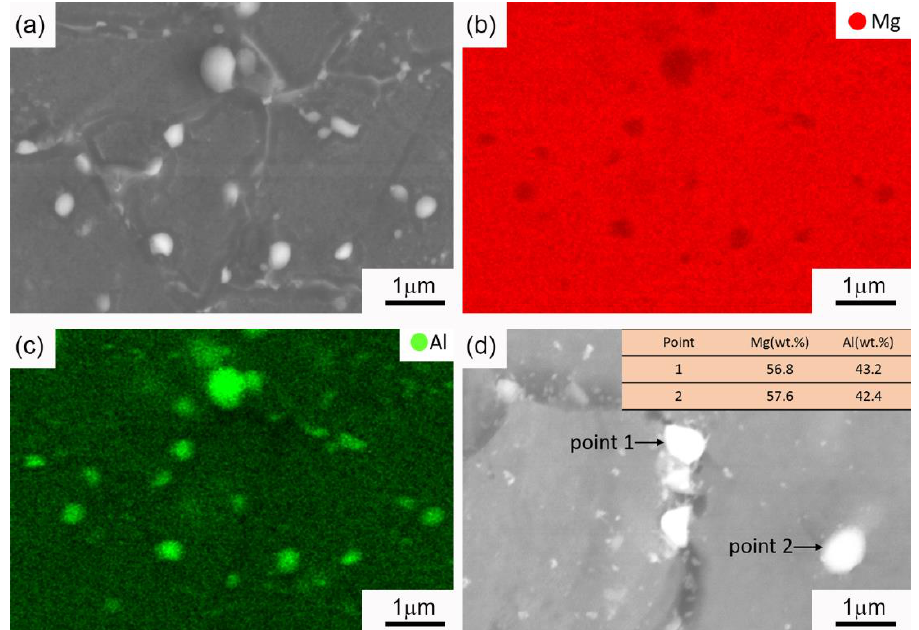
Figure 5. EDS analysis results of the as-rolled Mg-6Al plates: ( a ) SEM image, with corresponding elemental maps: ( b ) Mg, ( c ) Al, and ( d ) point analysis results of the second-phase precipitates.